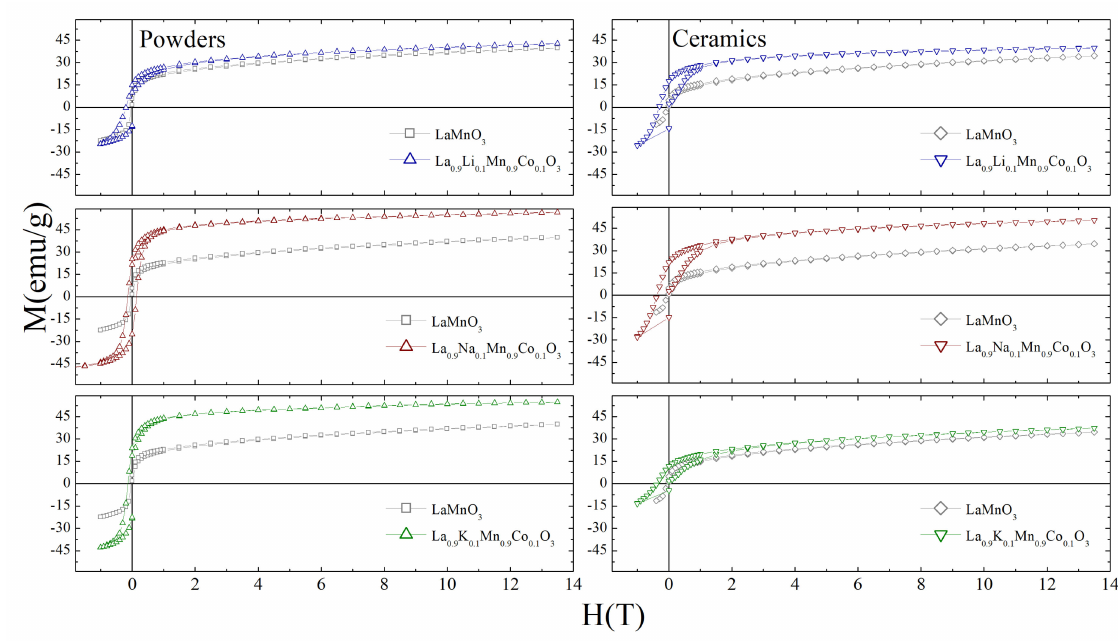
Figure 5. Isothermal magnetization curves measured for the initial LaMnO 3 and codoped La 0.9 A 0.1 Mn 0.9 Co 0.1 O 3 (A: Li, Na, K) powders ( left ) and ceramics ( right ) at T = 5 K (the graphs presented using the same